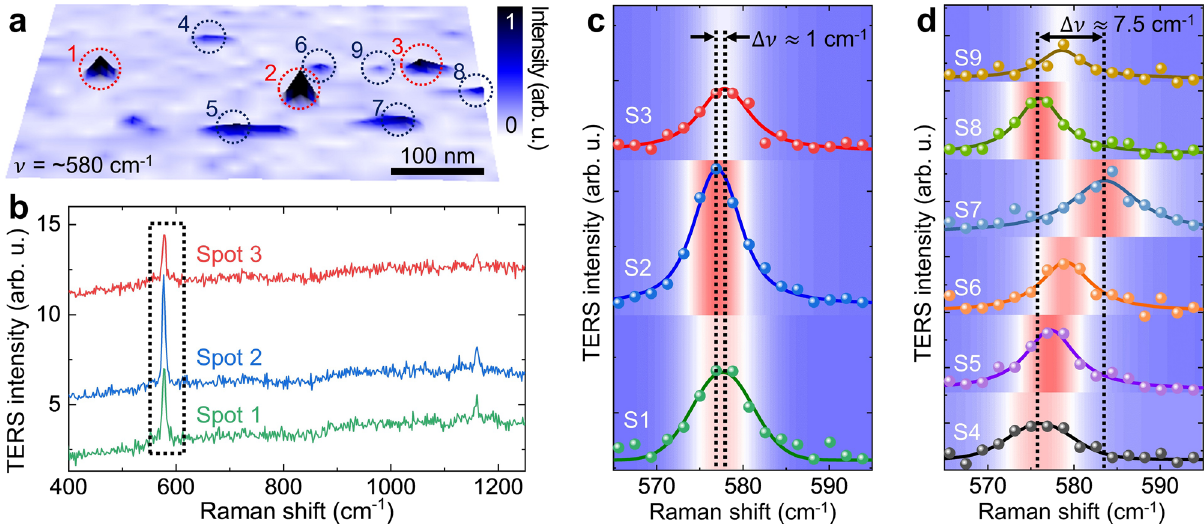
Fig. 4 TERS spectra of each isolated BCB molecules. a TERS peak intensity image of the vibrational mode at ~580 cm − 1 of BCB molecules. b TERS spectra measured at spots 1, 2, and 3 indicated with red circles in a . TERS spectra measured at spots 1 – 3 ( c ) and spots 4 – 9 ( d ) fi tted with the Voigt line shape function in the range from 565 cm − 1 to 595 cm − 1 . From the observed TERS peak shift in d , the TERS spectra at spots 1 – 3 (red circles in a ) are probably measured from molecular ensembles and spots 4 – 9 (dark blue circles in a ) are possibly measured from single or a few molecules. In c and d , the dots and lines are experimental data and fi tted curves, and the TERS spectra at each spot are also shown as background 2D contour images. Source data are provided as a Source Data fi